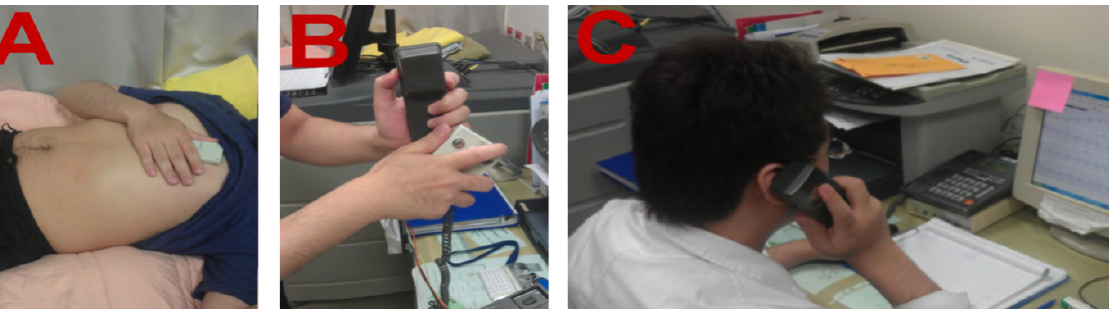
Figure 1. The demonstration of ECG transmission via telephone